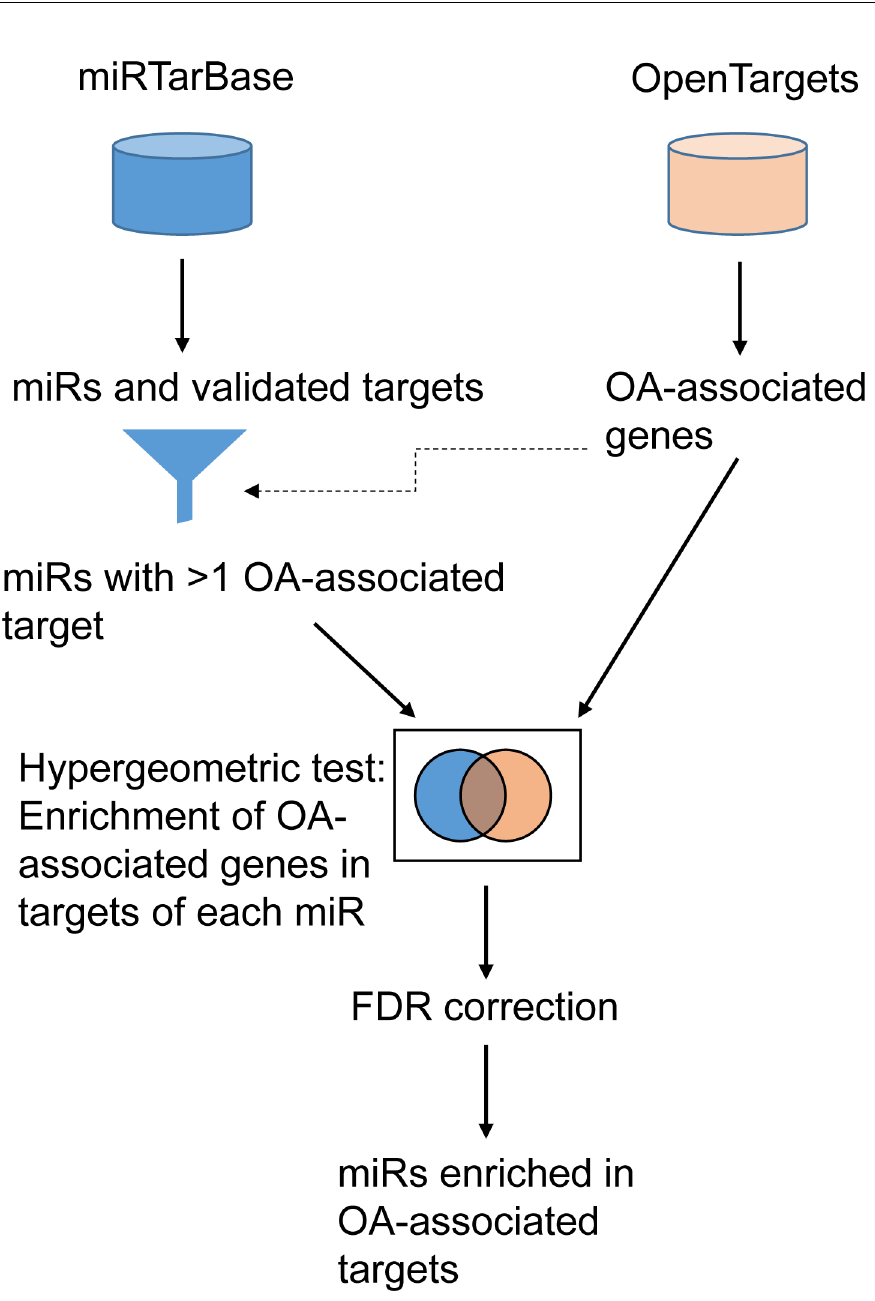
Fig 1. Identification and prioritisation of possible OA-associated miRNAs. Schematicrepresentingthe integrationof informationabout (left) validatedtargets of miRNAs and (right) OA-associated genes. The output is a list of miRNAs sorted by the multiple-test-corrected p-value of their enrichment in OA-associated